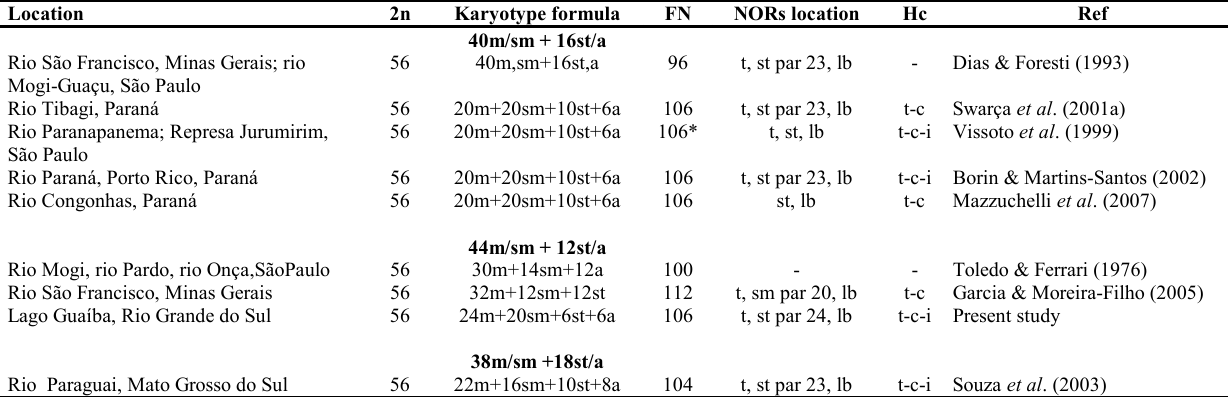
Table 1. Cytogenetic data for different samples of Pimelodus maculatus . 2n= diploid number; FN= fundamental number; NORs=nucleolar organizer regions; Hc= heterochromatin; Ref.= reference; t= terminal; c= centromeric; i= interstitial; lb= long arm; m= metacentric; sm= submetacentric; st= subtelocentric; a= acrocentric; *= FN recalculated in the present